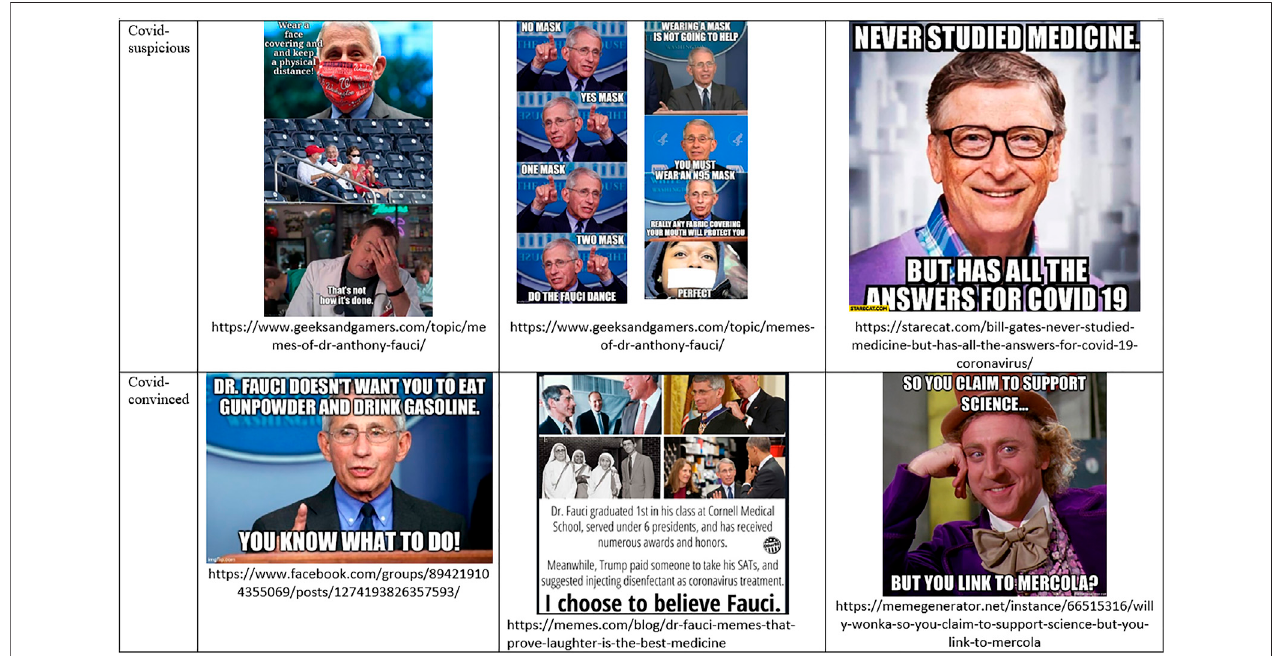
FIGURE 2 | Staging science by highlighting or undermining expert voices in Covid-skeptical and Covid-anxious memes.